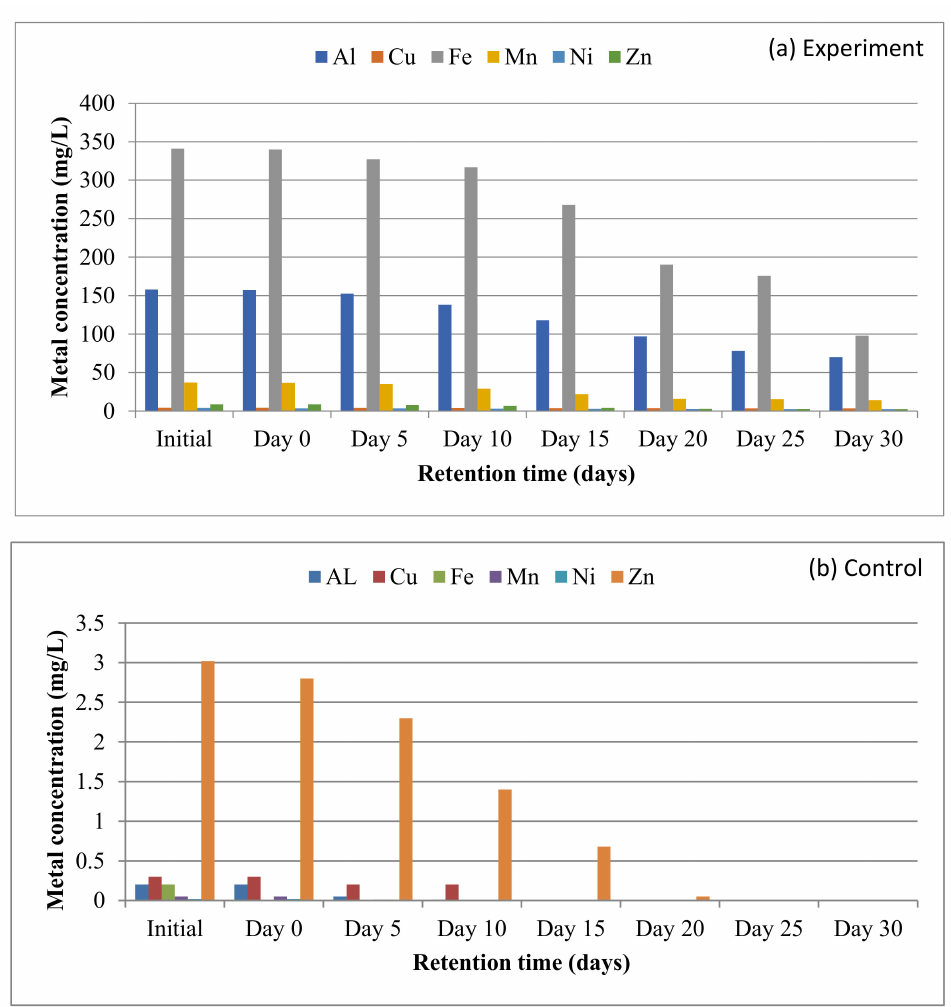
Figure 3. ( a ) Variation of the metal concentration in treatment wetland in 30 days of retention time under a hydraulic loading rate of 3 L/day. ( b ) Variation of metal concentration in control wetland in 30 days of retention time under a hydraulic loading rate of 3